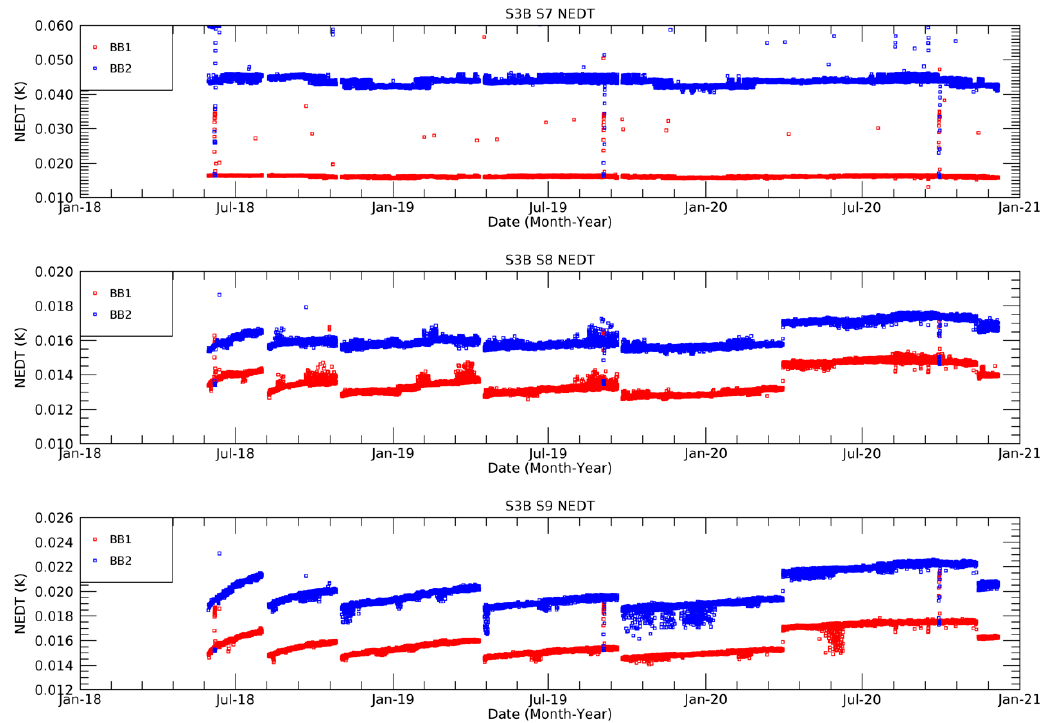
Figure 15. Time series for the period from May 2018 to December 2020 of SLSTR-B NEDT (Fully Random Uncertainty) derived from the on-board BB targets at ~262 K (blue) and ~302 K (red).